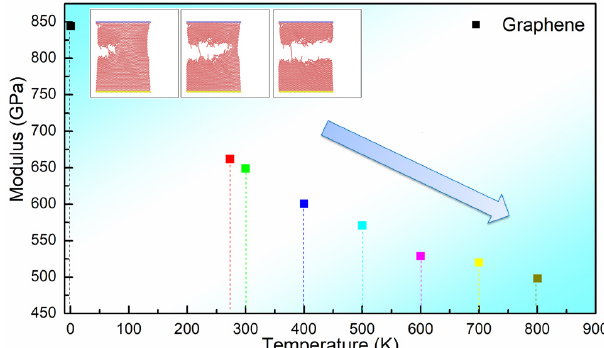
Figure 5. Calculated modulus of perfect graphene at different temperatures.